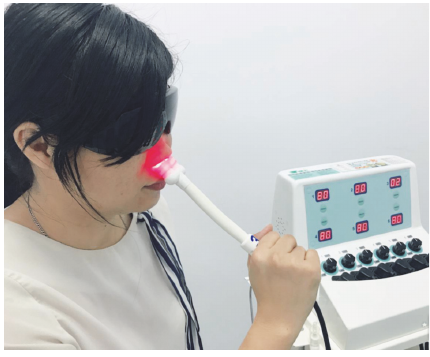
Figure 2: A patient receiving red light rhinophototherapy through two light-emitting nasal